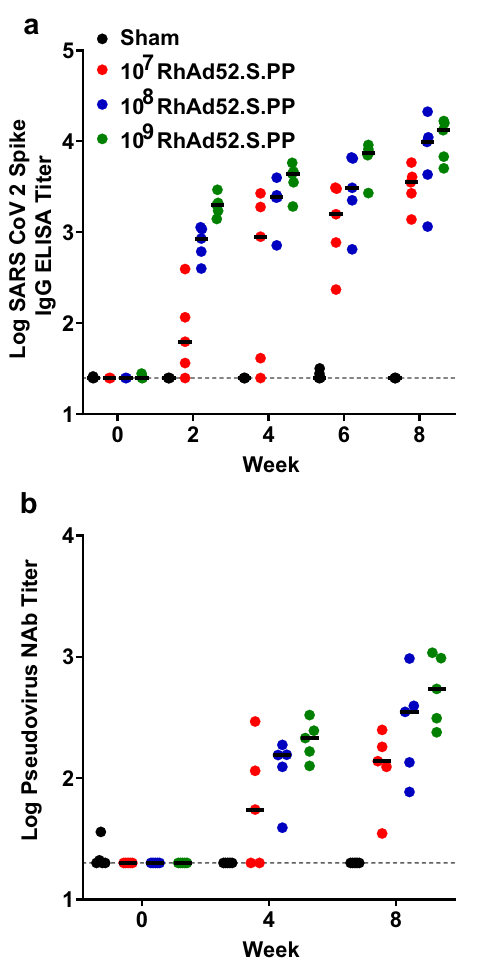
Fig. 3 RhAd52.S.PP vaccine titration to generate suboptimal humoral responses. a , b IgG binding titers against full-length SARS- CoV-2 WH Spike protein ( a ) and neutralizing Ab titers against SARS- CoV-2 WH pseudovirus ( b ) measured over the course of 8 weeks in BALB/c mice vaccinated intramuscularly with RhAd52.S.PP at 10 7 (red dots), 10 8 (blue dots), and 10 9 (green dots) particles per mouse. Each dot represents an individual animal. Median values denoted as black